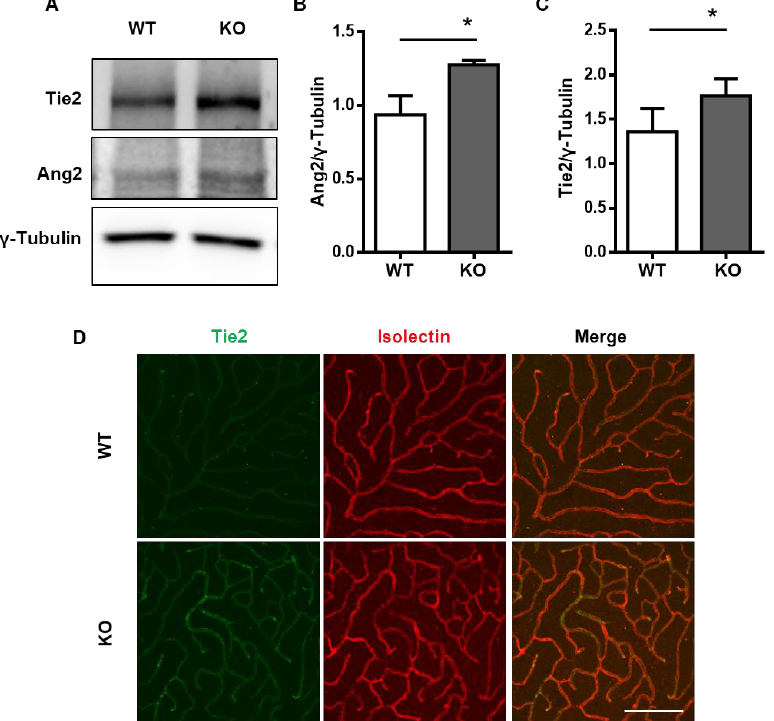
Figure 1. Tie2 is upregulated in the NDPK-B-deficient retina. ( A ) Representative immunoblots of Tie2, Ang2, and γ -Tubulin in NDPK-B − / − retinal lysates. ( B , C ) Quantification of Ang2 and Tie2, respectively, normalized to γ -tubulin, showing upregulation of Tie2 in NDPK-B-deficient retinas ( n = 5), WT: wild type, KO: NDPK-B − / − , * p < 0.05. ( D ) Expression of Tie2 (green) and Lectin (red) in the deep capillary layer of wild type (WT) and NDPK-B − / − (KO) retinas, depicting elevated Tie2 in the deep capillary layer of NDPK-B − / − retina compared with control retina. The pictures shown are representative of staining from three animals in each group, scale bar 50 µ